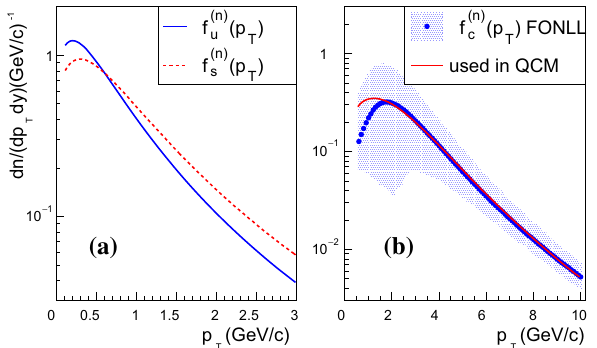
Fig. 1 a The normalized p T spectra of light quarks at mid-rapidity in √ pp collisions at s = 7 TeV; b that of charm quarks. The shadow area shows the scale uncertainties in FONLL calculation